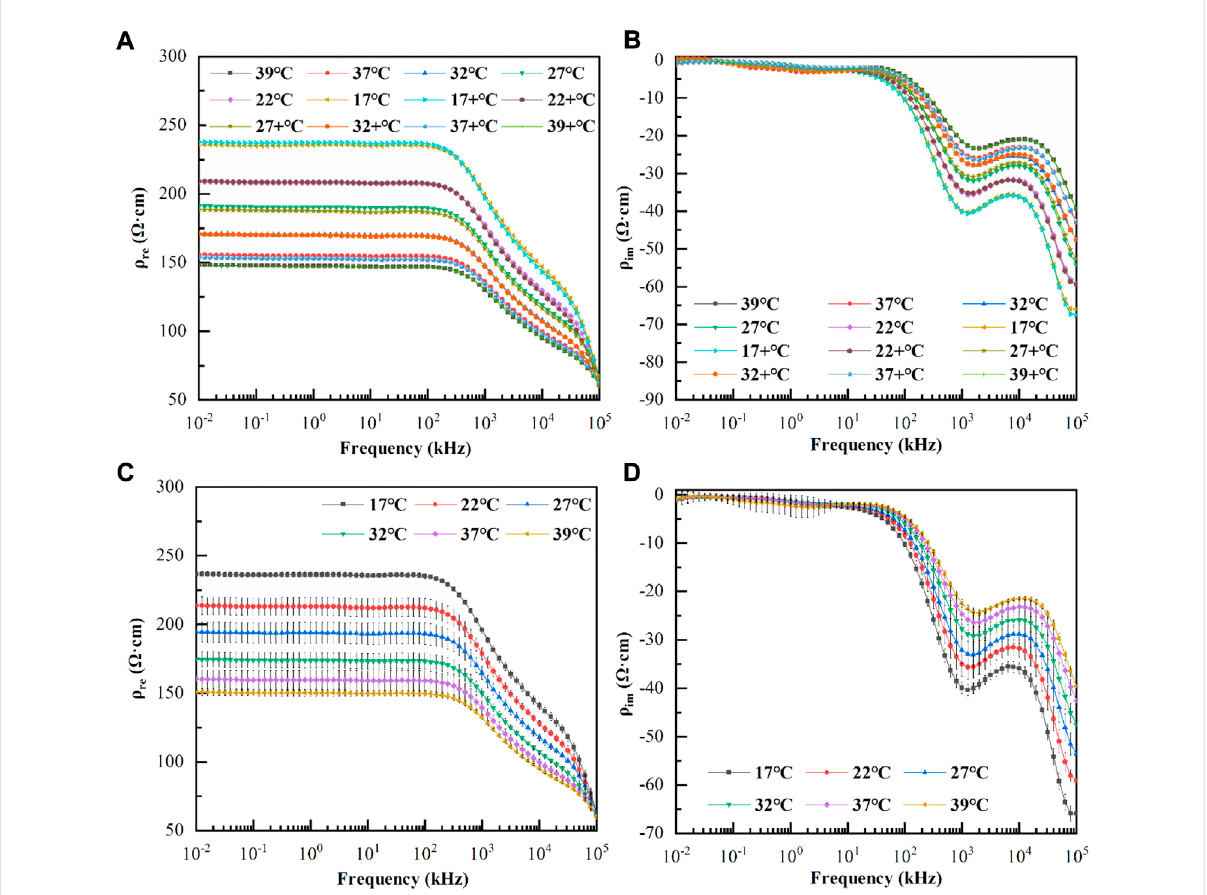
FIGURE 4 (A) : Variation of the real parts of resistivity with frequency during cooling and rewarming; (B) : Variation of the imaginary parts of resistivity with frequency during cooling and rewarming; 39 ° C, 37 ° C, 32 ° C, 27 ° C, 22 ° C, and 17 ° C indicate the corresponding temperatures during the cooling process, while 17+ ° C, 22+ ° C, 27+ ° C, 32+ ° C, 37+ ° C, and 39+ ° C indicate the corresponding temperatures during the rewarming process. (C) : Variation of the mean value of the real parts of resistivity with frequency at each temperature (The error bars are standard deviations); (D) : Variation of the mean value of the imaginary parts of resistivity with frequency at each temperature (The error bars are standard